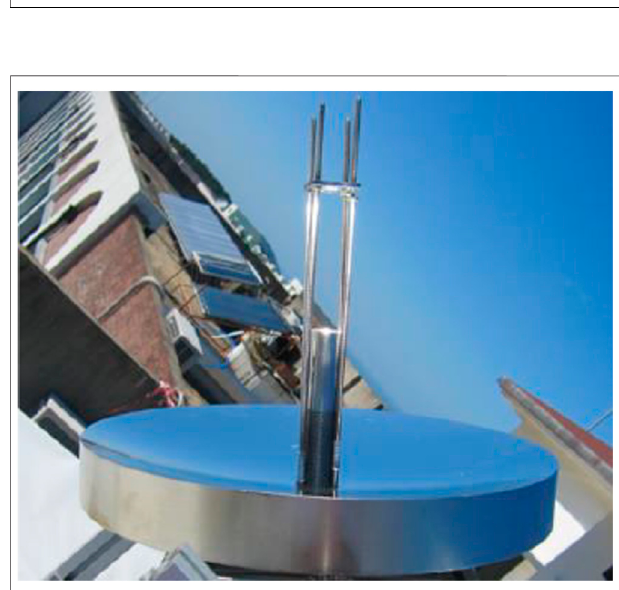
FIGURE 2 | Assembly of the solar concentrator